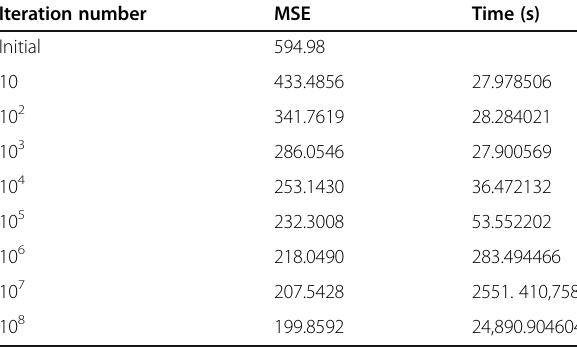
Table 1 MSEs for the Shepp-Logan phantom study without noise. Computation times are also